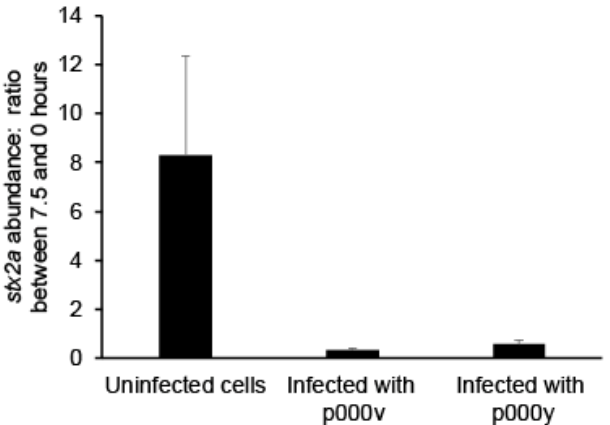
Figure 3. Quantification of prophage 933W induction in phage-infected STEC cultures via qPCR. The Shiga toxin ( stx2 subunit a ) gene abundance in prophage 933W is measured at 0 and 7.5 h post-phage addition to STEC cell cultures at multiplicities of infection (MOIs) of ~4.6 (for phage p000y) and ~6.4 (for phage p000v). Represented is the ratio of such stx2a abundance between 7.5 and 0 h of STEC growth, using the average of the biological replicates and their error, either in the absence (left most bar in the graph) or presence (the other two bars) of phages. The differences between in the absence of phages (uninfected cells) and in the presence of phages (infected with p000v or p000y) are statistically significant ( p < 0.05). Table 2. Summary of the prophage induction quantification obtained by qPCR in uninfected and infected STEC cultures, as presented in Figures 2 and 3. Stx2a Copies Per µL During STEC Growth with and without Phage